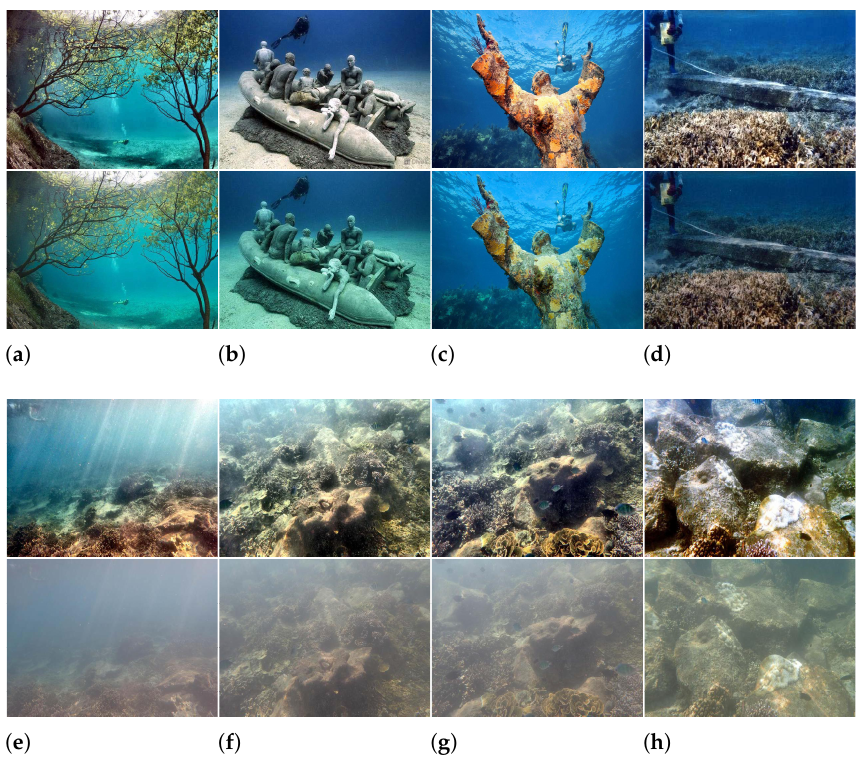
Figure 10. ( a – h ) are image pairs selected from UIEB, in which the upper image of each pair is the image after enhancement and the lower image is the image before enhancement. Table 7. Judgment results of each evaluation method on 8 pairs of images in the UIEB